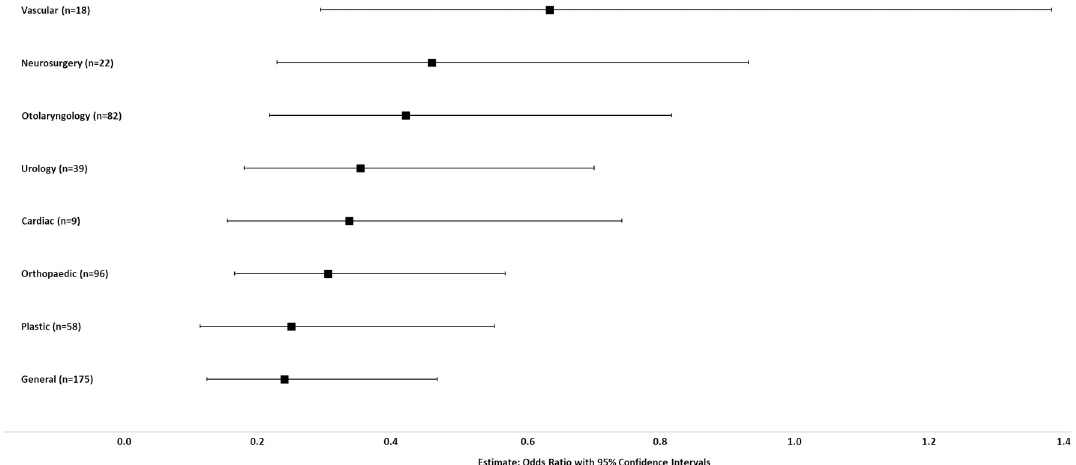
Fig 7. Prediction modeling of the impact of surgical specialty on likelihood of women academic surgeons attaining highest levels of leadership (Department, Division or Section Head). Controlled for university and higher degrees. Odds ratio with 95% confidence interval graphed for each specialty compared to the reference specialty (Thoracic Surgery, 0.14, highest proportion of women at the highest levels of leadership).